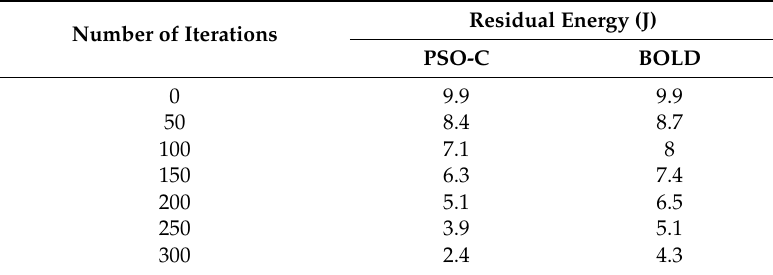
Table 4. Residual energy (J) vs. number of iterations.